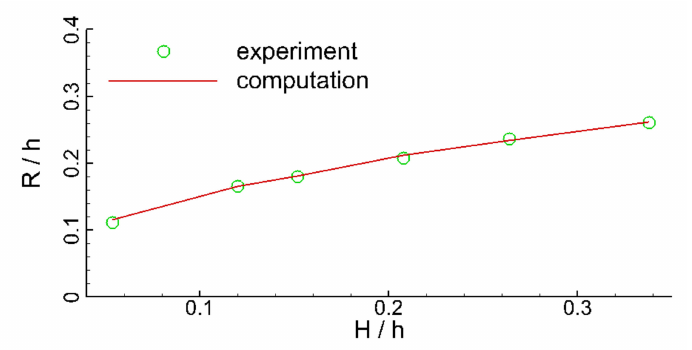
Figure 7. Comparison of maximum wave runup height for the experimental data and the